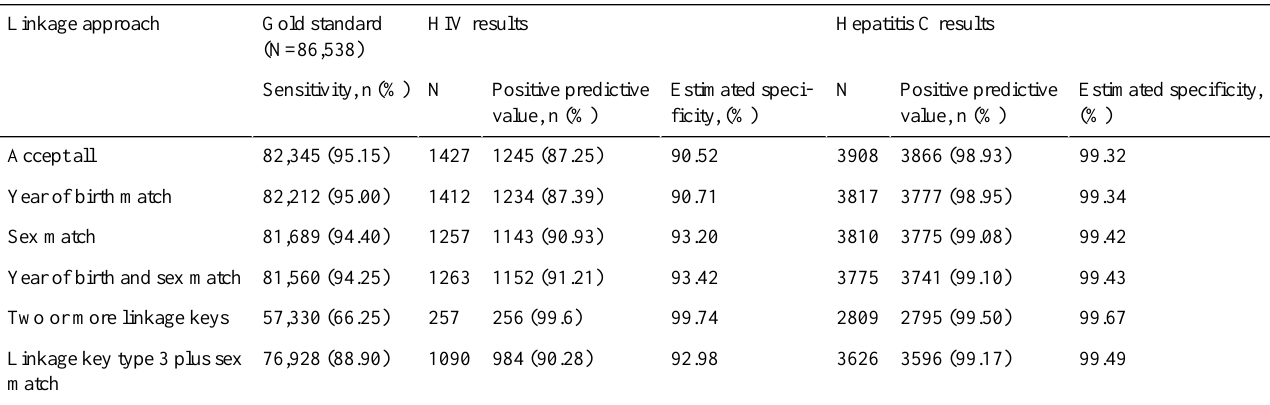
Table 5. Evaluation measures derived from using the GRHANITE Linkage Tool on the pathology results gold-standard dataset.